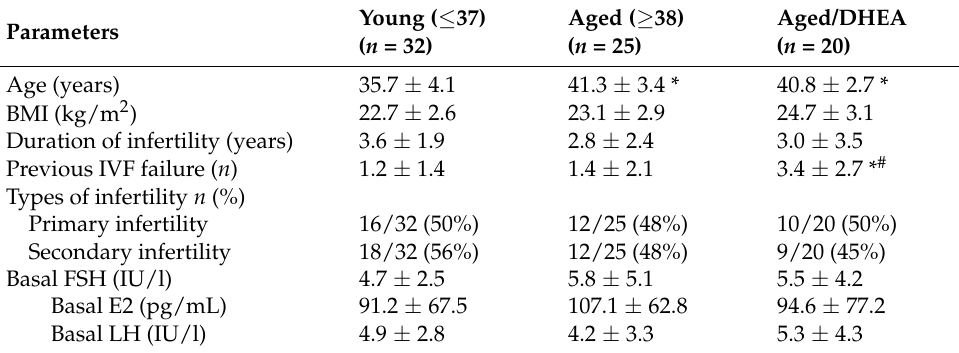
Table 2. Cycle characteristics and pregnancy outcome in the young, aged, and aged/DHEA groups.